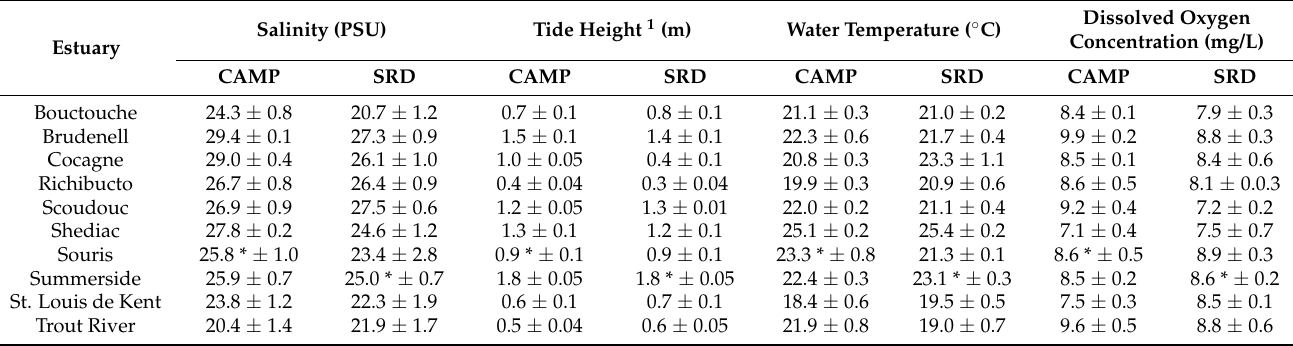
Table 2. Summary of environmental data collected using the Community Aquatic Monitoring Program (CAMP) and Stratified Random Design (SRD) sampling designs at each estuary sampled in 2016. Data are means ( ± standard error) of station data ( n = 6) collected for each sampling